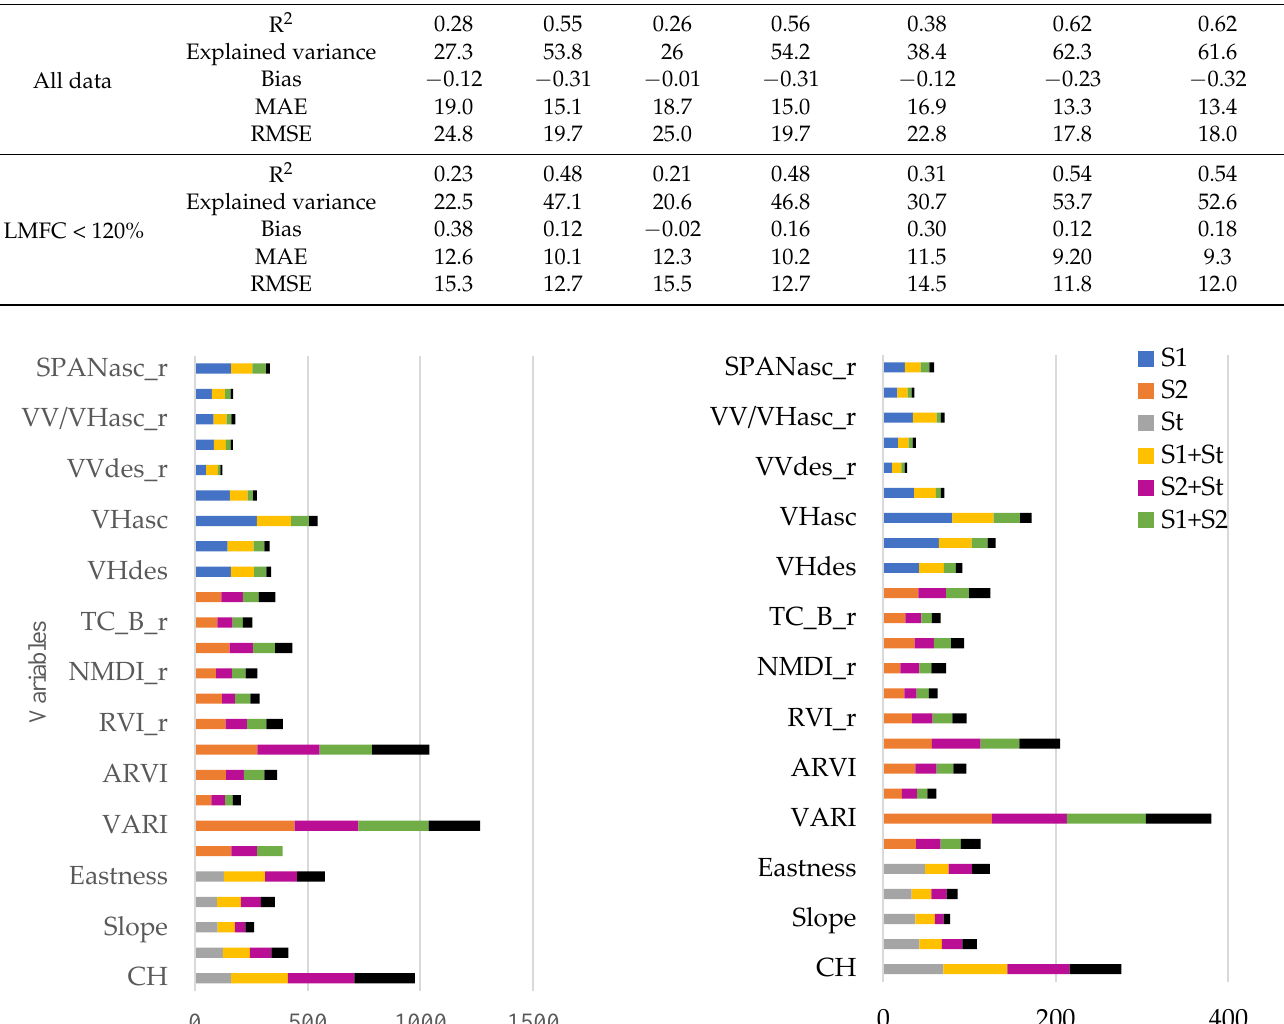
Table 5. LFMC retrieval error as a function of the predictor variables. S1 stand for Sentinel-1 variables, S2 for Sentinel-2 variables, and St for static variables. In bold are the most accurate estimates.